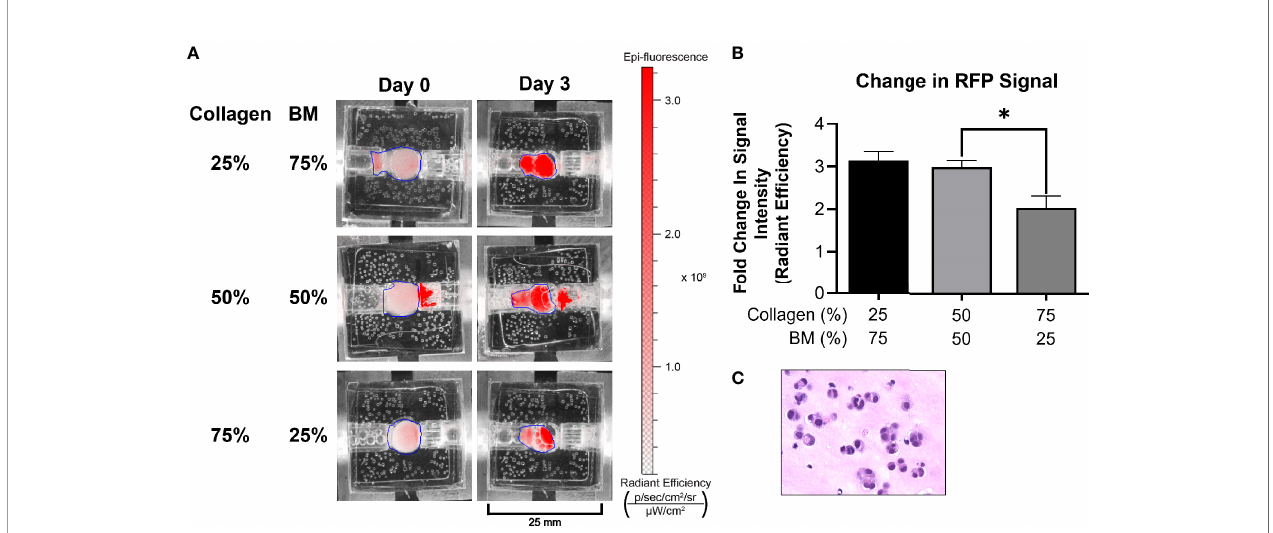
FIGURE 2 | Optimization of ECM composition. (A) A medullary thyroid cancer (TT) cell line stably transfected with RFP grew optimally in 25/75 and 50/50 ECM composition, as depicted by IVIS imaging. All other experiments were performed utilizing the 50/50 ECM composition. (B) Following three days ’ culture, total radiant